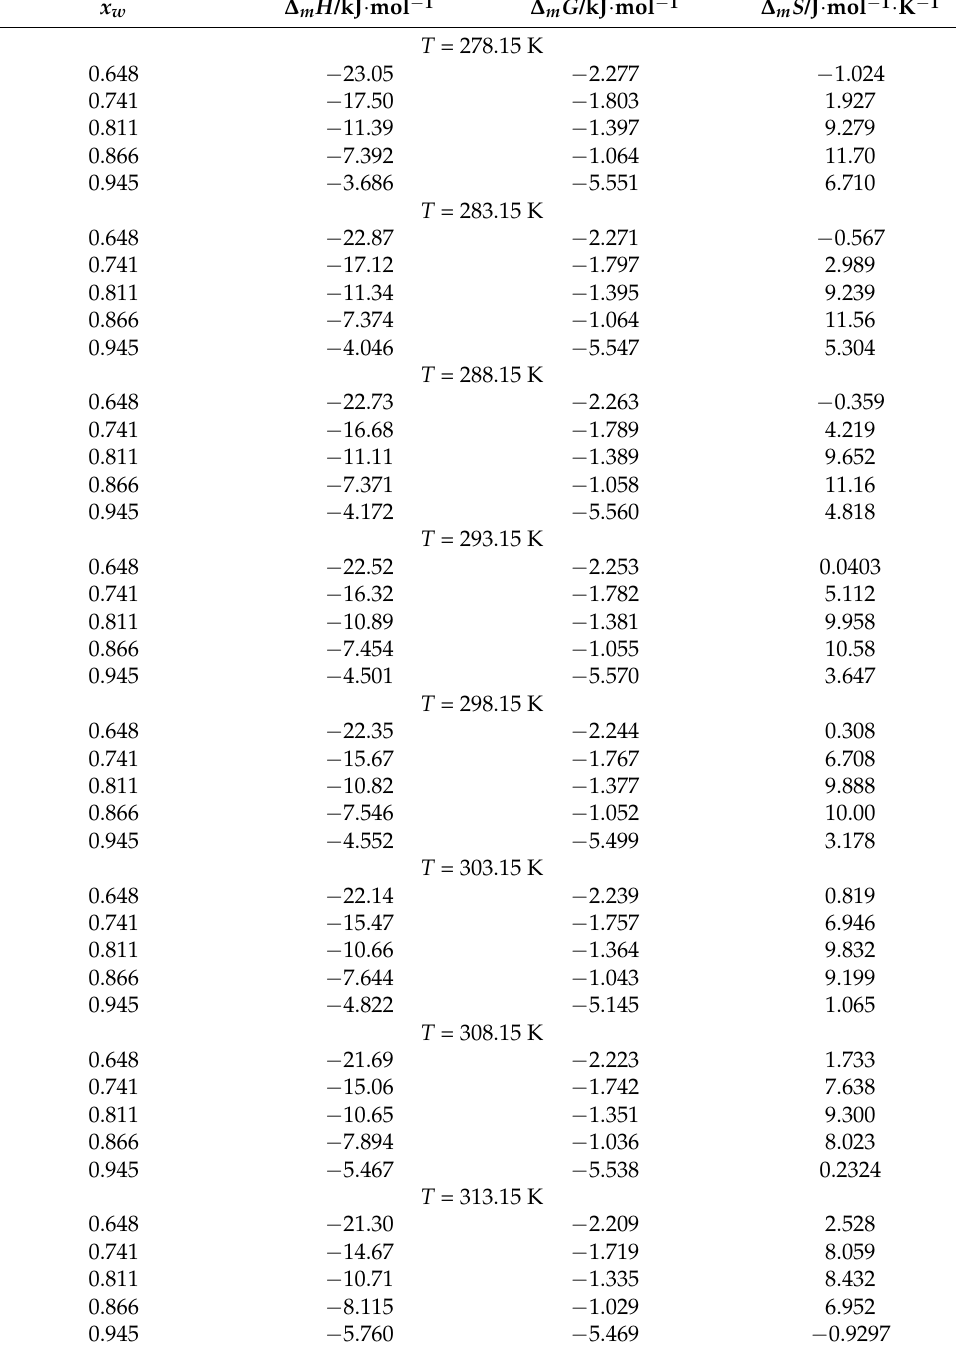
Table 12. Mixing thermodynamic properties of 1,5-pentanediamine adipate dihydrate in water +DMF mixtures a,b